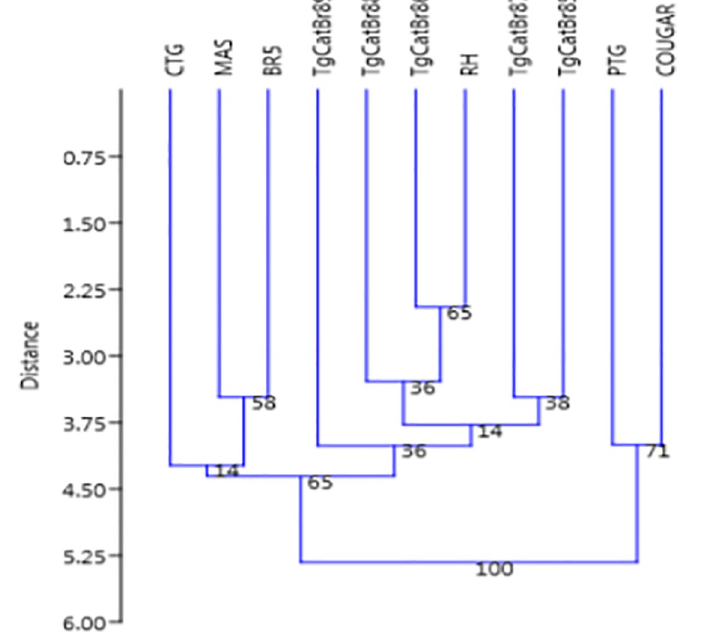
Strains isolated from the southern Bahia region were considered virulent, compared to those from the Salvador region. The TgCatBr 86 and 88 isolates found in this study were grouped in cluster I. The isolates TgCatBr 85, 87, and 89 were grouped in cluster III (Table 2). Through cluster analysis, the isolates were grouped into two clusters, Type I and Type III, based on the similarities of the isolates within each type. The dendrogram of the genotypes, as assessed by the neighbor-joining method, demon- strated that the isolates in this study were close to the RH isolates (closest to Type I) (Fig 1).